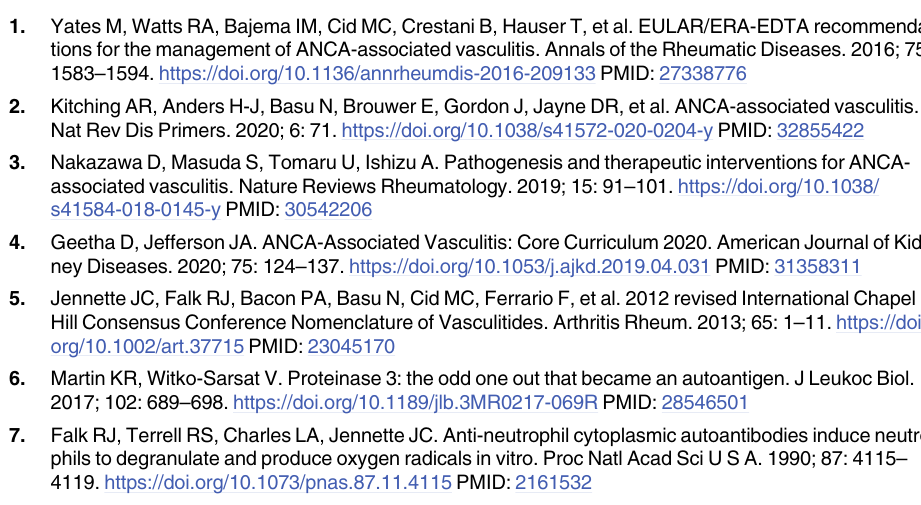
n = 21) using the Truecount method. NDGs were identified as CD16 + SSC + cells in whole blood. Each dot represents one measured patient sample. Patients receiving prednisolone dos- ages of � 20mg daily (3 patients with GPA and one patient with SLE) are indicated by trian- gles. Median values ± IQR are presented. Data were analyzed by Kruskal-Wallis-test, no significant differences were determined. B) Microscopy images of netting neutrophils. Rep- resentative immunofluorescence images to identify NETs formed by normal-density granulo- cytes (NDG) from one healthy donor and one patient with GPA without stimulation (upper row) or after certain time-points after PMA stimulation. S1 Table. Patient characteristics in which NETs have been investigated as depicted in Fig 3.